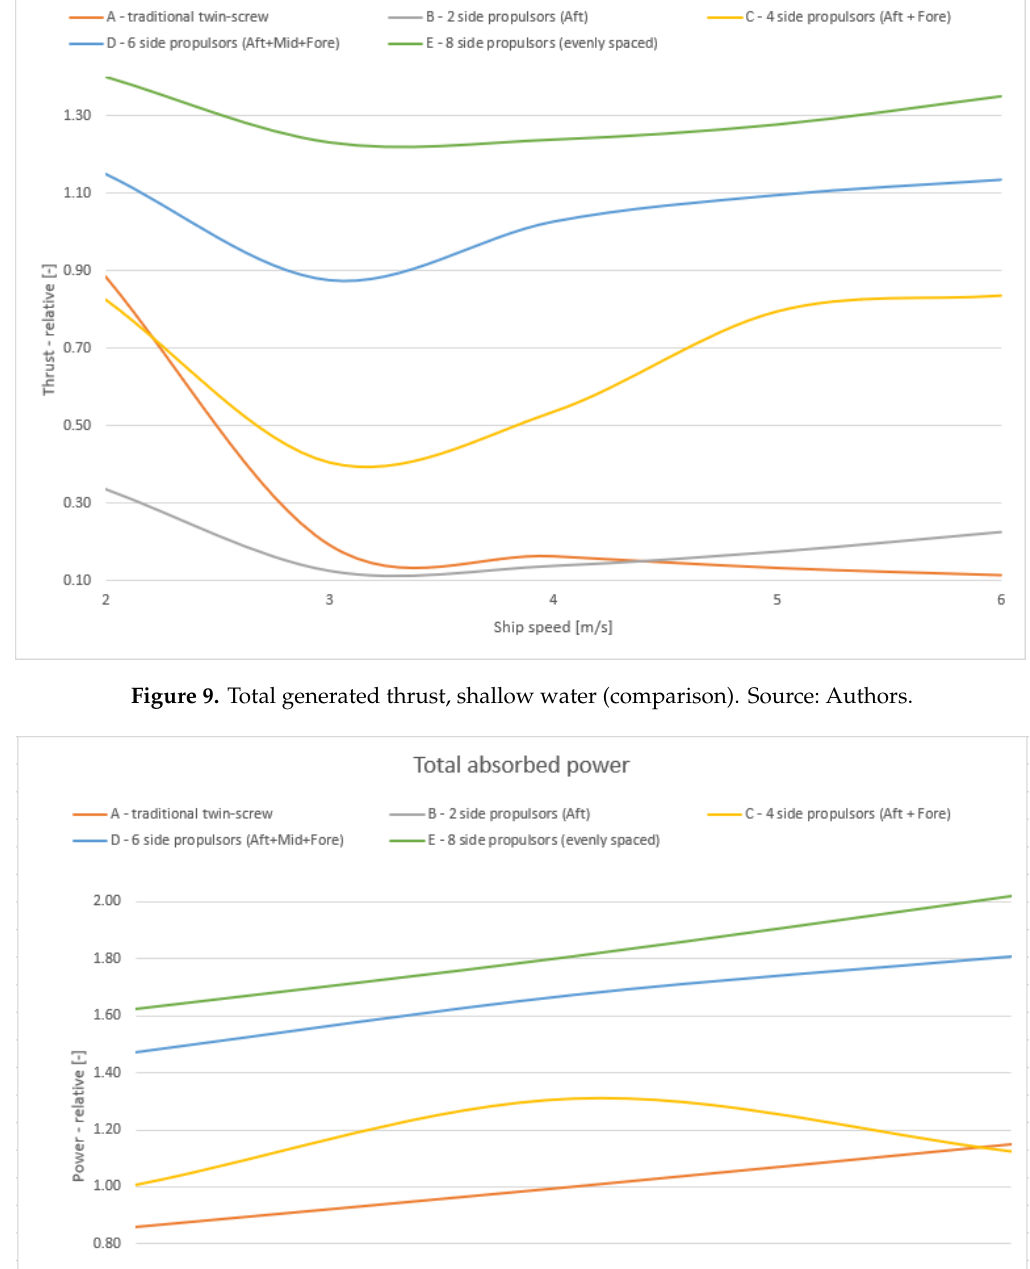
Figure 8. Total generated thrust, deep water (comparison). Source: Authors.